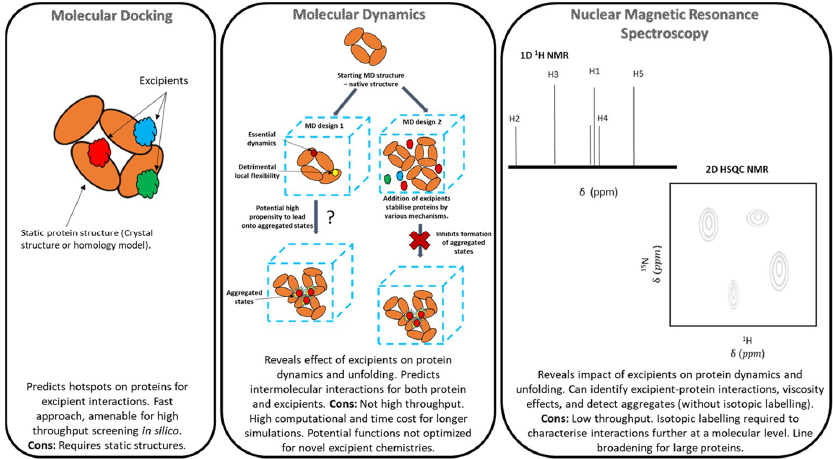
Figure 1. A schematic representation of the potential of in silico molecular docking, molecular dynamics simulation, and NMR spectroscopy to elucidate protein-excipient interactions to inform the rational design of protein-based formulations.